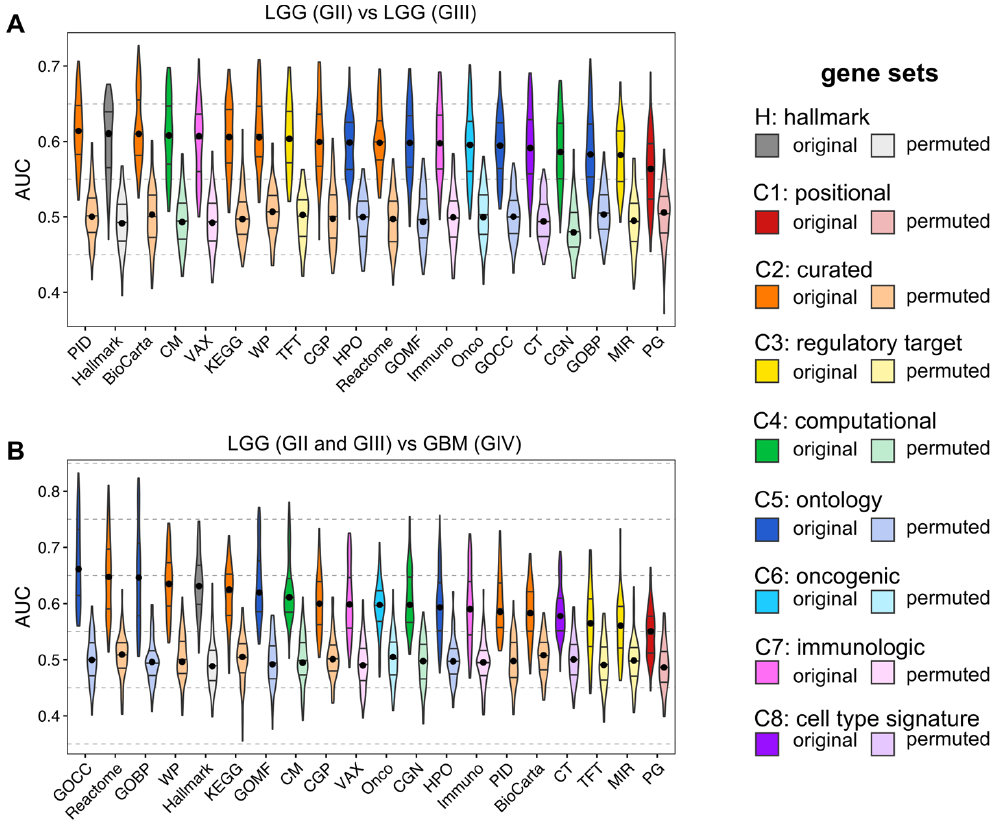
Figure 2. Evaluation of MSigDB collections using ML models for discerning glioma grades using ssGSEA scores for classifying ( A ) GII vs. GIII and ( B ) LGG vs. GBM. Five different ML approaches were used: SMO, IBk, Bagging, J48 and JRip. Each ML method was undersampled 20-times with 10-fold CV. The median was marked with a black dot on each violin.